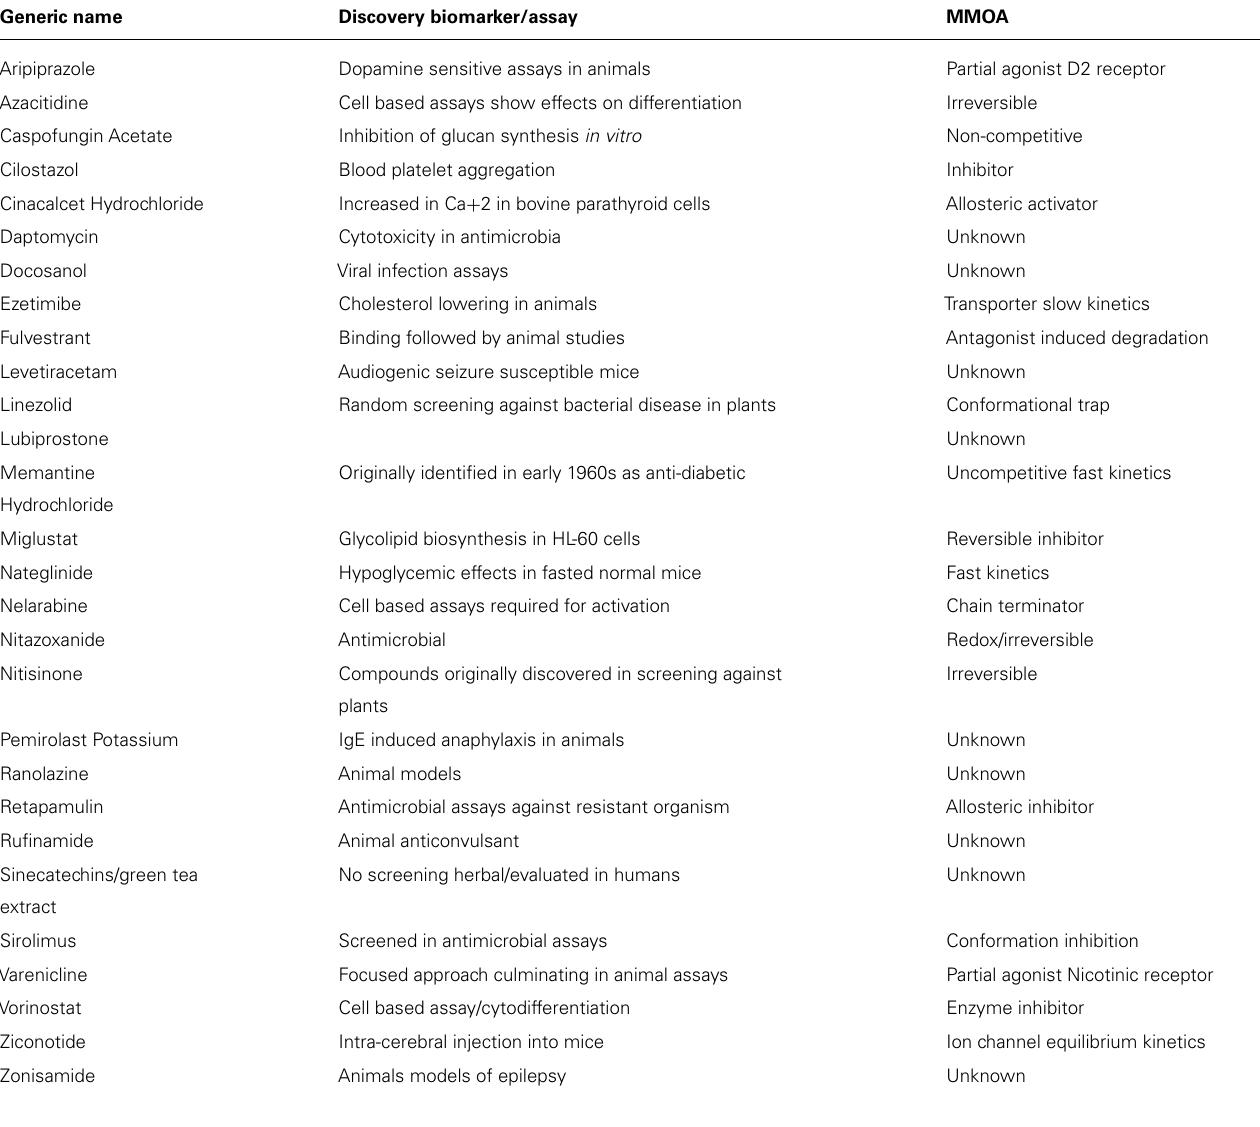
Table 1 | Discovery biomarkers for phenotypic assays of NMEs approved by US FDA between 1999 and 2008 (Swinney andAnthony,